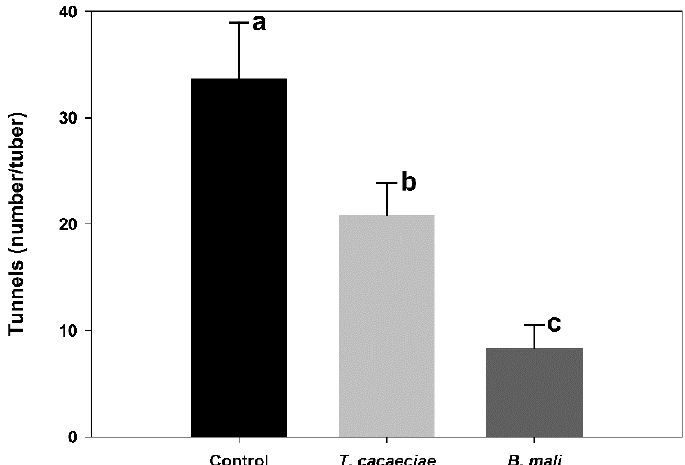
Figure 2. Damage by P. operculella : mean number of tunnels ( ± SE) per potato tuber after 49 days, when an initial release of the predatory mite B. mali or the parasitoid T. cacaeciae was carried out, with respect to the control, under storage conditions (values with different letters indicate significant differences at p = 0.01).